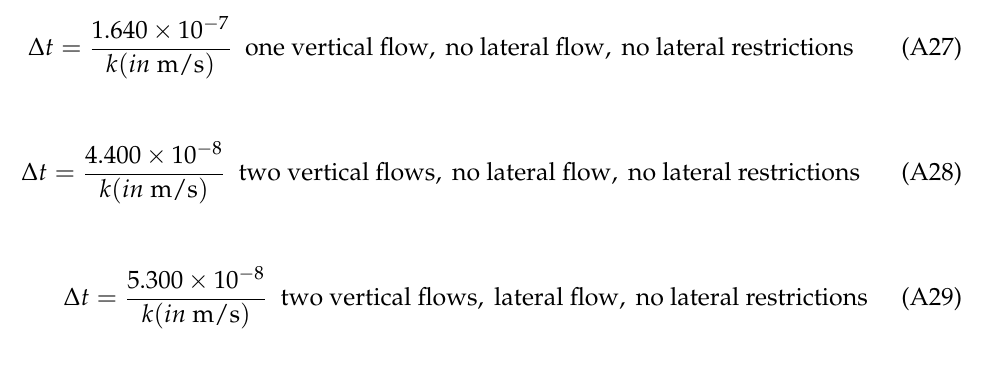
Figure A4. Calibration curves of the elastoplastic coupled model under vertical flow, lateral flow, and no lateral restraints.